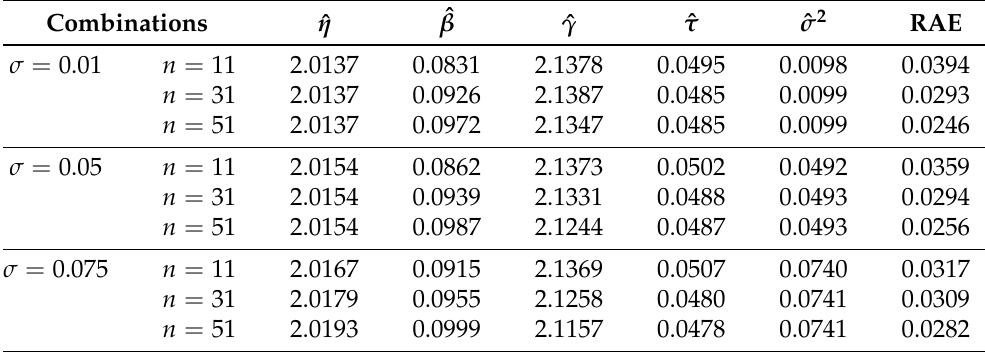
Figure 4. Observed mean vs. estimated mean obtained from simulated sample paths with the estimated parameters, for the case of a hyperbolastic process of type II. Table 5. Final solutions for simulated data of the H 3 process and RAE to estimated mean. Original parameters are η = 2, β = 0.1, γ = 2.3, and τ =